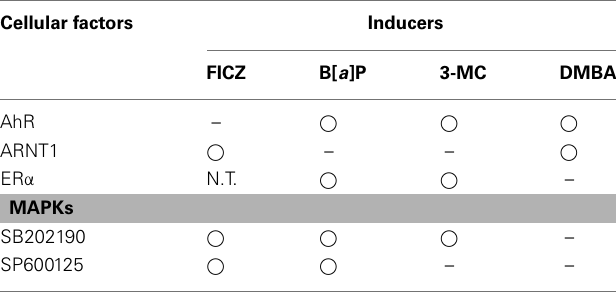
Table 1 | Summary of cellular factors required for L1-RTP by environmental compounds.